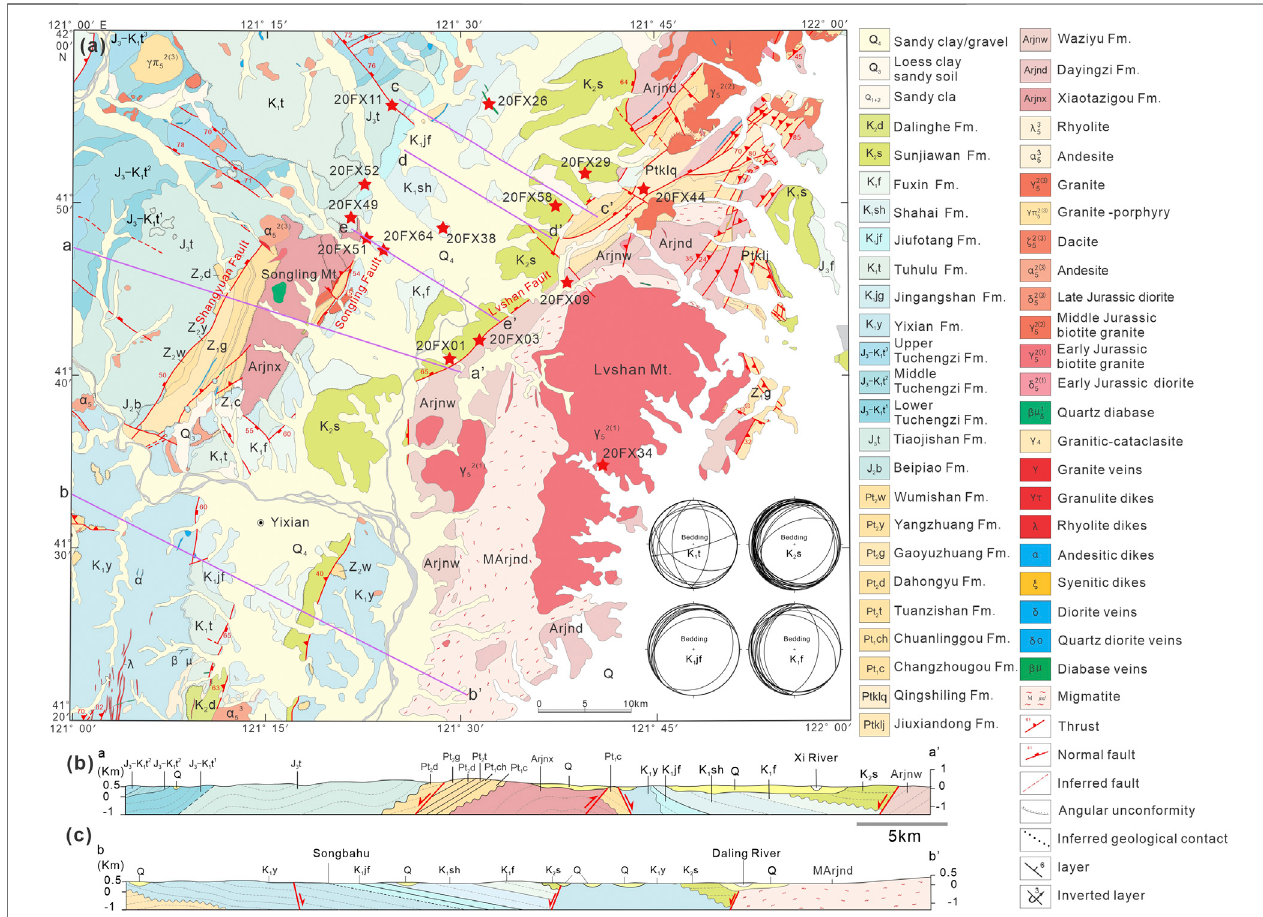
FIGURE3| Geological map and transects ofthe FuxinBasinonthe Liaodong Peninsula (modi fi edafter the Regional Geological Map ofYixian,scale1:20,000). (A) Geological map of the Fuxin Basin and adjacent area, showing the strata, faults, observation sites (red stars), and section lines. (B,C) Sections of NW – SE transects through the Fuxin